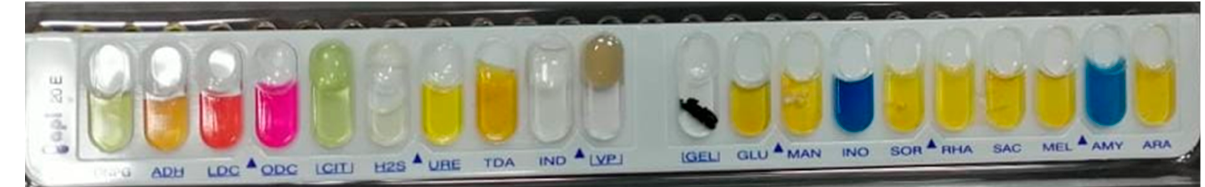
Figure 1. The biochemical profile of obtained E. coli isolates via API 20E system. The E. coli isolates were serotyped to nine different serotypes; the isolate with the highest incidence was O125 ( n = 18), followed by O55 ( n = 8) and O86 ( n = 7), while the other serotypes were O111 ( n = 6), O127 ( n = 5), O159 ( n = 4), O18 ( n = 4) O157 ( n = 2) and O166 ( n = 2).